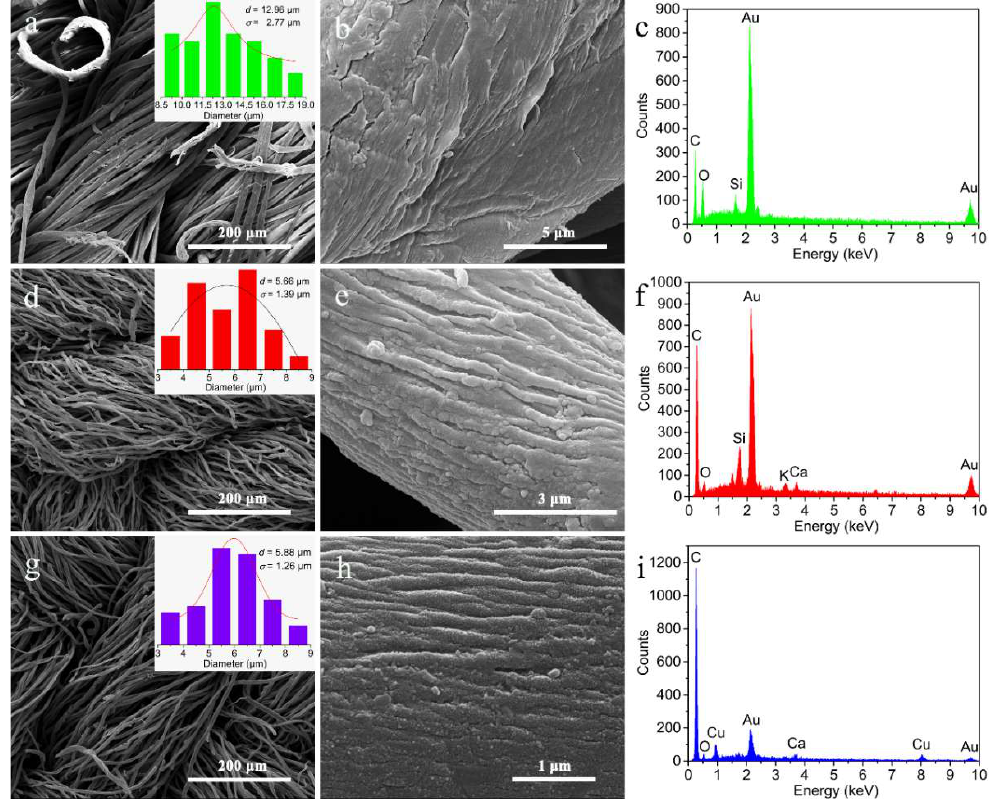
Figure 2. SEM images and EDX patterns of the cotton fibers ( a – c ), CDCFs ( d – f ) and nano-Cu/CDCFs ( g – i ): ( a , d , g ) distribution state of fibers and insets show the corresponding diameter distribution of fibers; ( b , e , g ) surface observation of single fiber; ( c , f , i ) EDX patterns.